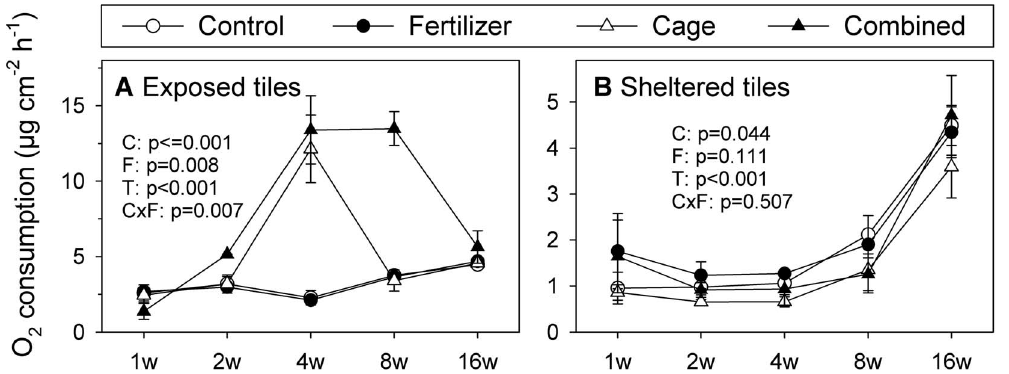
Figure 5. O 2 consumption rates. O 2 consumption rates of A: light-exposed tiles and B: shaded tiles in m g cm 2 2 h 2 1 (means 6 SE). P-values are calculated from 3-factorial ANOVA and originate from analysis across the whole study period (see Table 5 for full test results). Significant p-values (p , 0.05) are indicated by asterisks. Abbreviations: C=Cage, F=Fertilizer, T=Time.